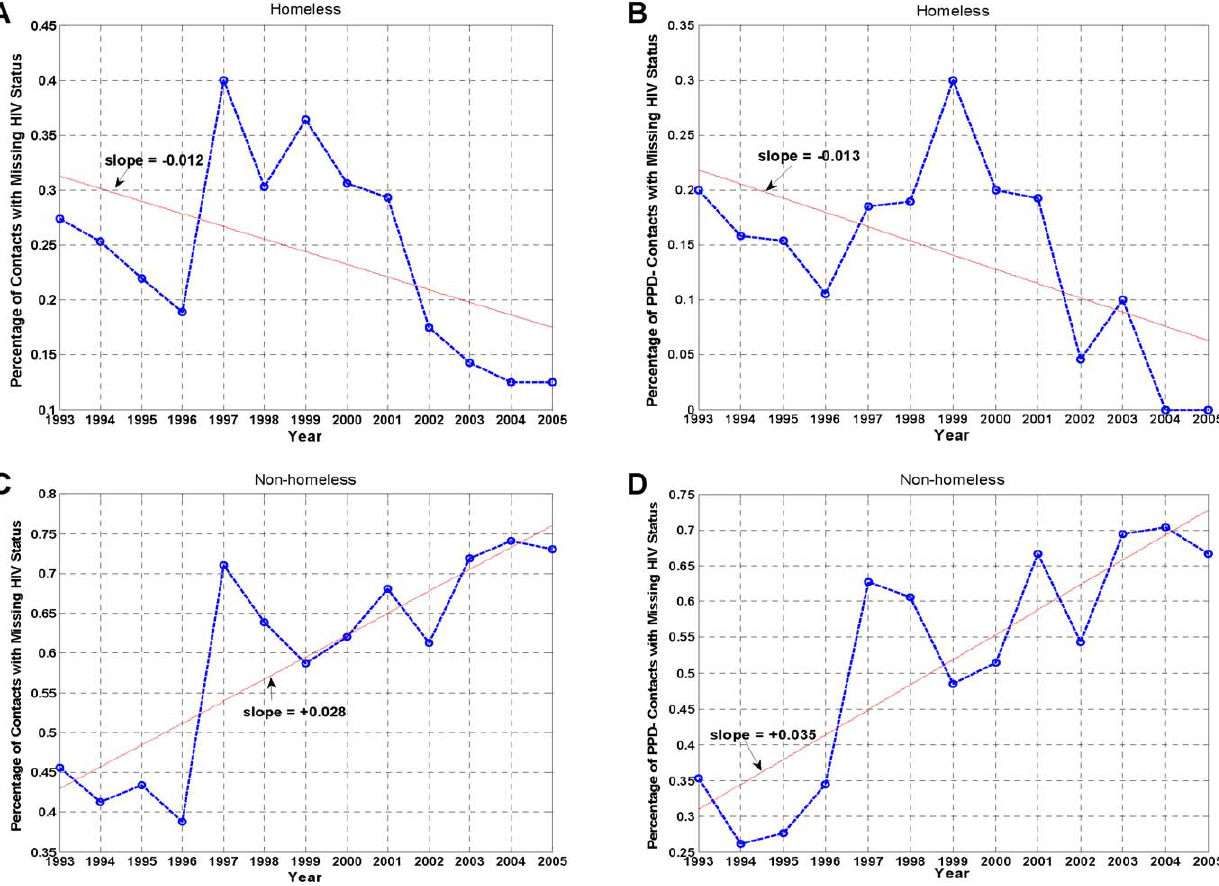
Figure 3. Annual percentage of all contacts and PPD 2 contacts with missing HIV status, January 1993–December 2005. (A and B) Homeless. (C and D) Non-homeless. In A and C, contacts include both PPD + and PPD 2 individuals. While the reporting of HIV status has improved over time among all contacts and PPD 2 contacts in the homeless population (negative slopes), it has worsened among the non-homeless (positive slopes). Red line: linear fit.